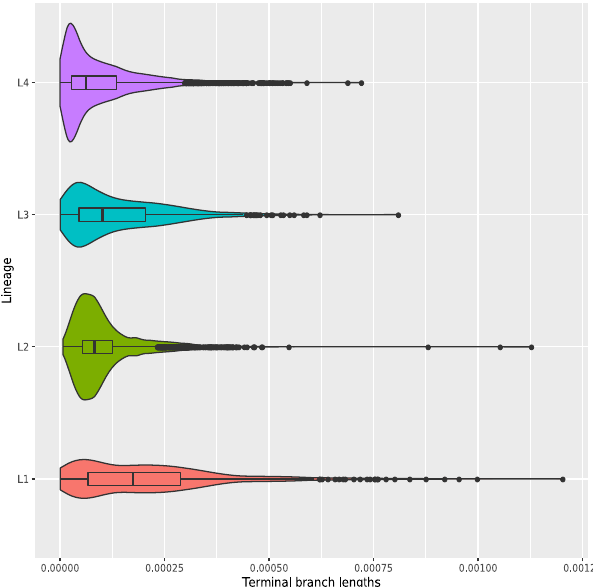
Fig. 9 Distributions of terminal branch lengths for the four global